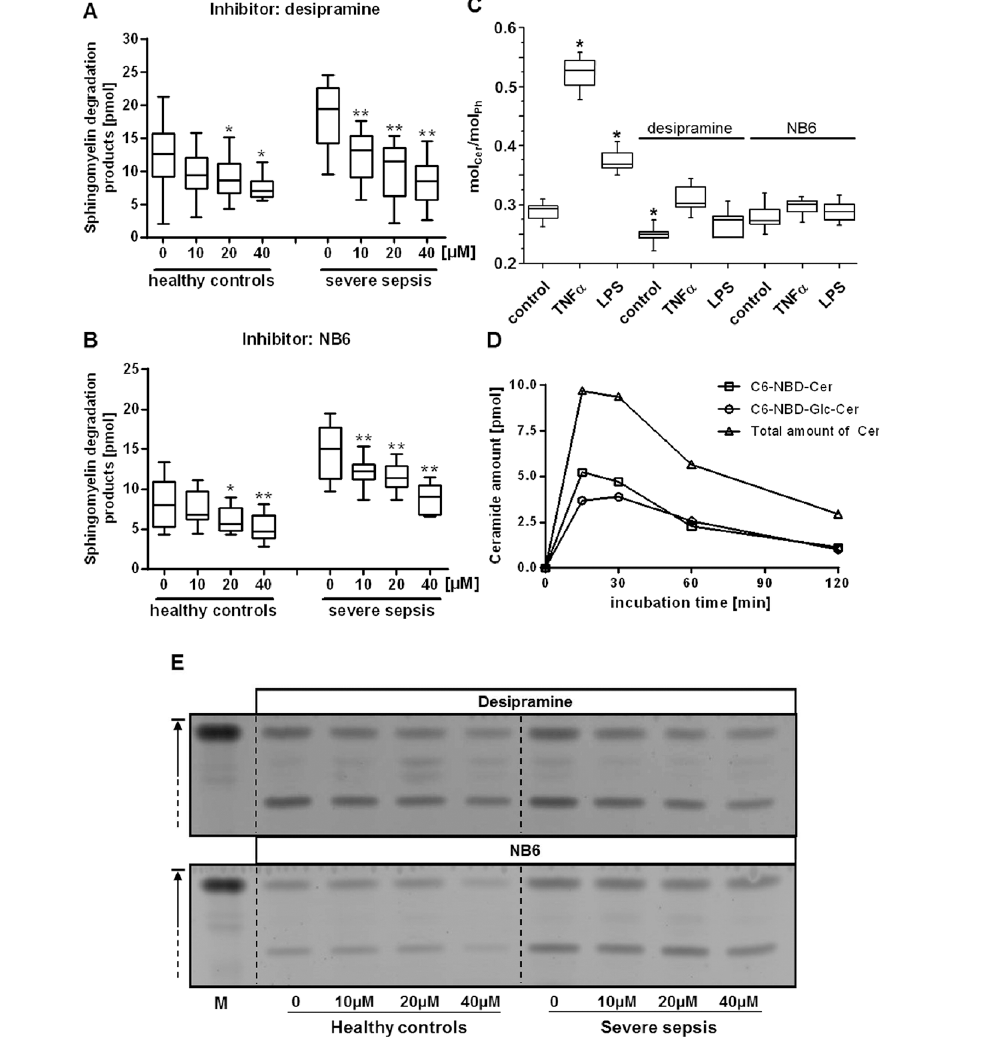
Figure 2. Inhibition of ceramide generation by (A) desipramine and (B) NB6. Semi-confluent HMECs were metabolically labeled with C -NBD-sphingomyelin and stimulated with serum (5%) obtained from healthy individuals (n = 12) or patients with severe sepsis for 6 20 min (n = 12). Monolayers were pretreated with desipramine or NB6 for 30 min (10, 20, 40 μmolar). Boxes indicate the interquartile range, divided by the median (central horizontal line) as analyzed in twelve independent experiments per group. Significant differences in comparison to monolayers without desipramine or NB6 pretreatment were calculated by Friedmann-Wilcoxon test with adjustment according to Bonferoni-Holm results are indicated by asterisks (* p < 0.05, ** p < 0.02). (C) Ceramide generation in proinflammatory stim- ulated endothelial cells. Semi-confluent HMECs were pretreated with desipramine or NB6 for 60 min (20 μmol each), and stimulated with TNF- α (10 ng/mL) or endotoxin (100 ng/mL) for 240 min in the presence of 5% human serum from healthy individuals. Subsequent to lipid extraction, purification and labeling, ceramides were separated by HPLC. Shown is the total amount of ceramides, since the boxes indicate the interquartile range, divided by the median (central horizontal line) as analyzed in six independent experiments. Significant differences to basal values are indicated by an asterisk (* p < 0.05). (D) Time course of sphingomyelin breakdown in stimulated endothe- lial cells. Semi-confluent HMECs were metabolically labeled with C -NBD-sphingomyelin and stimulated with serum (5%) obtained from 6 patients with severe sepsis. Fluorescent sphingolipids such as ceramide as well as GlcCer were separated by TLC quantitated by den- sitometry. Representative results from three independent experiments are shown. (E) Representative sphingolipid pattern of stimulated endothelial cells used for densitometric analyses. Endothelial monolayers were pretreated with desipramine (upper lines) and NB6 (lower lines) for 30 min (10, 20, 40 μmolar). Fluorescent sphingolipids such as ceramide (r 0.8) as well as GlcCer (r 0.6) were separated by TLC f f and quantitated by densitometry. Representative results from 24 independent experiments (12 each per group and inhibitor, providing data for A and B) are shown. M,